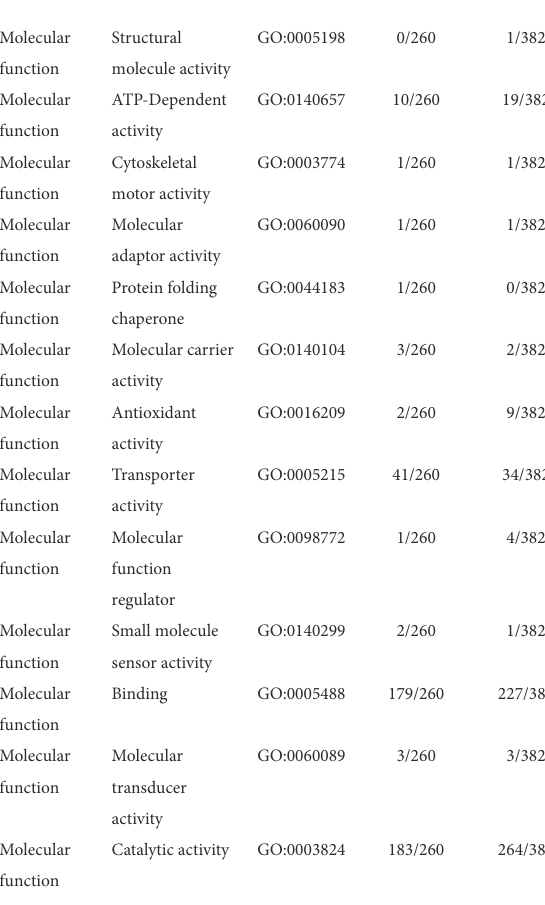
TABLE 2 GO categories of differentially expressed proteins in Escherichia coli